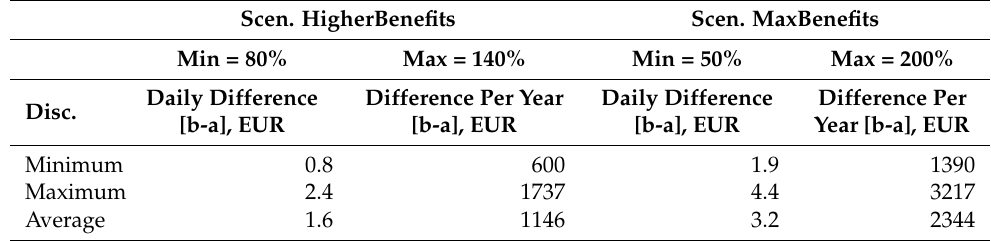
Table 5. Scenario analysis of economic effects. Scen. HigherBenefits Scen. MaxBenefits Min = 80% Max = 140% Min = 50% Max = 200% Daily Difference Disc. [b-a],